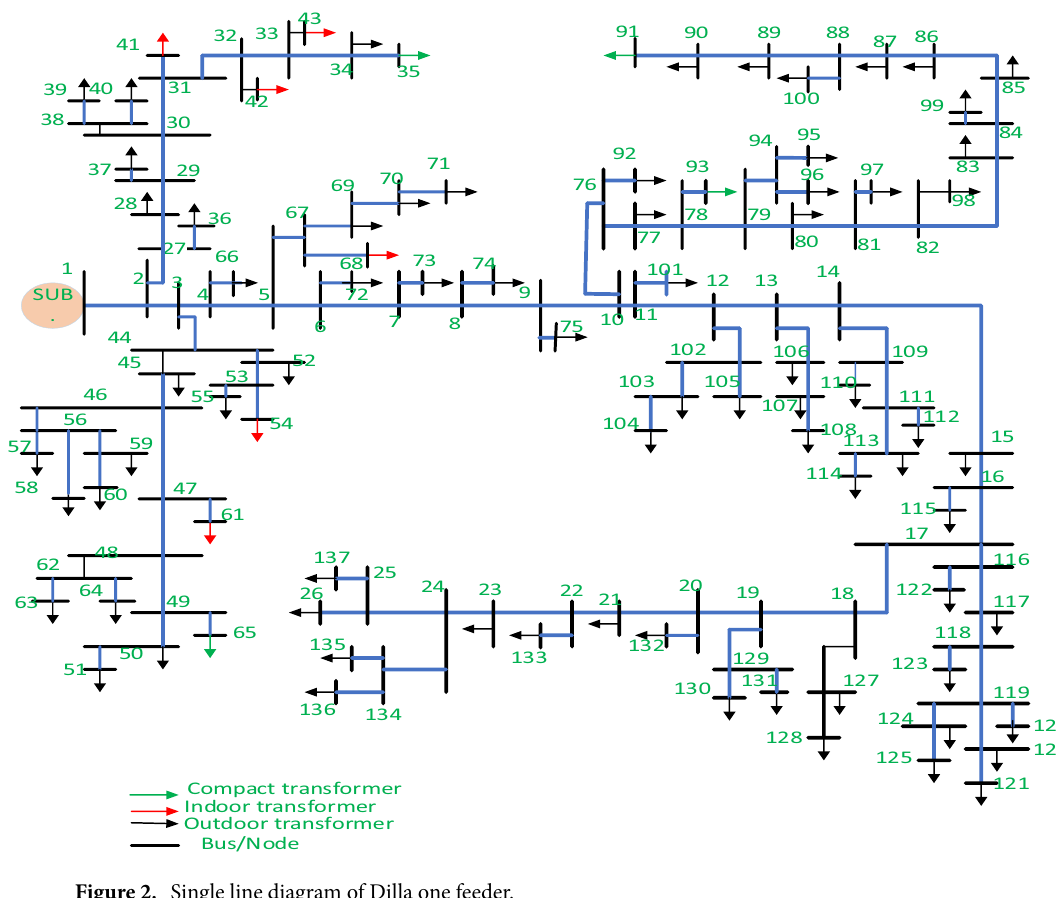
Figure 2. Single line diagram of Dilla one